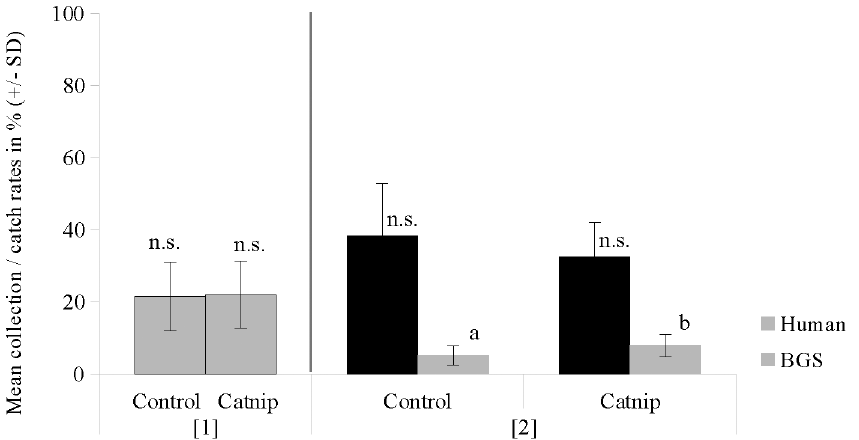
Fig 7. Human collection & BGS catch rates (means ± standard deviation) of Ae. aegypti in semi-field trials of the FFS. The x-axis shows test scenarios: [1] BGS as attracting stimulus inside the tent and [2] Human volunteer inside the tent plus BGS O (= push-pull situation). Different lowercase letters indicate significant differences at p < 0.04 (Mann-Whitney-U-test, n = 10). n.s. = non